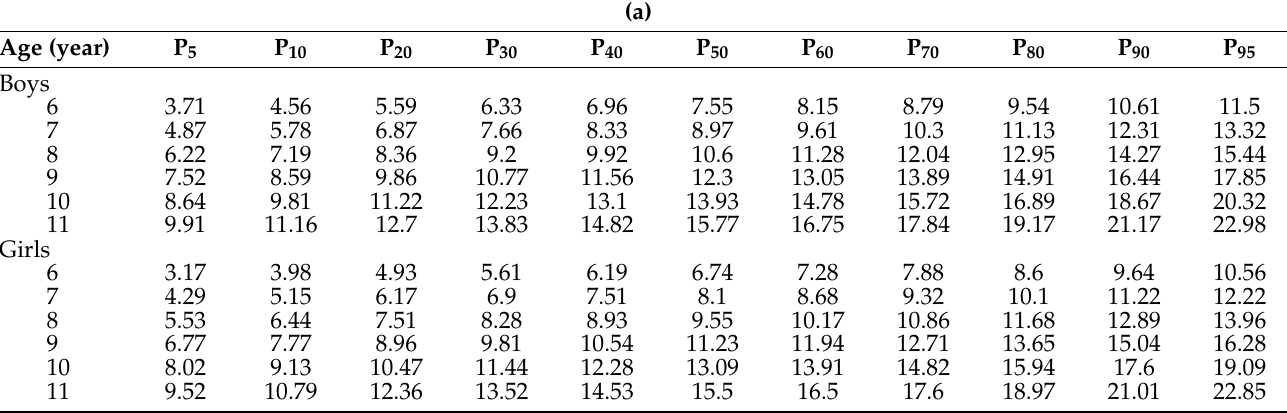
sex and age in 9 to 17-year-old Hong Kong children and